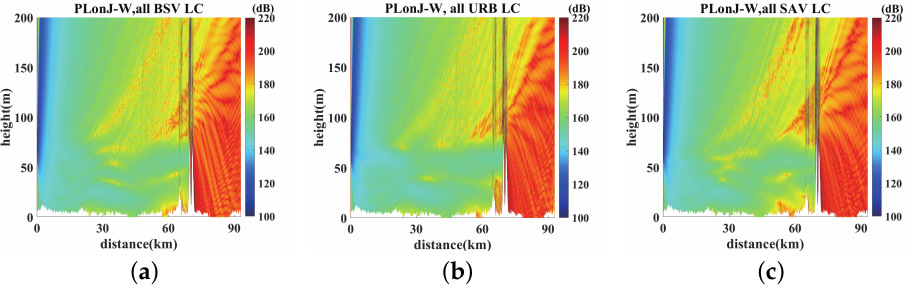
Figure 23. The MSE of PL using the improved TWPE between IGBP LC and different LCs on Shanghai–Wuxi. ( a ) PL on J–W with BSV LC. ( b ) PL on J–W with URB LC. ( c ) PL on J–W with SAV LC.